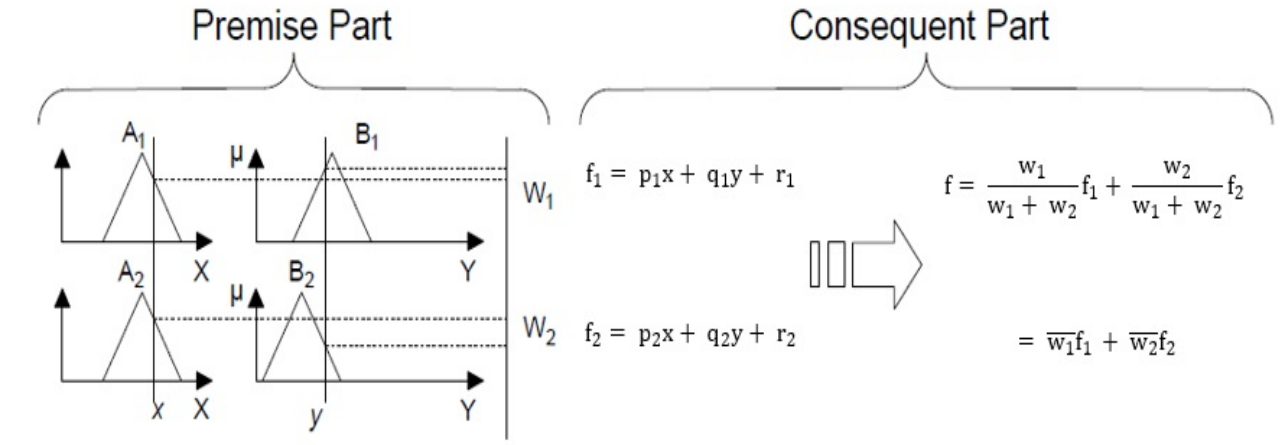
Figure 1. General ANFIS architecture of first-order Takagi–Sugeno fuzzy model. The membership functions A and B are shown as triangular functions in Figure